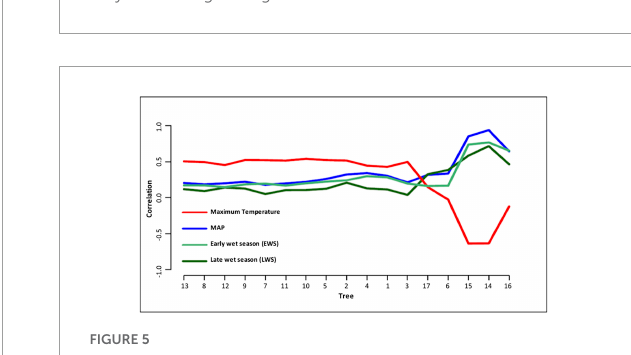
FIGURE4 20 year moving average of the coefficient of variation.